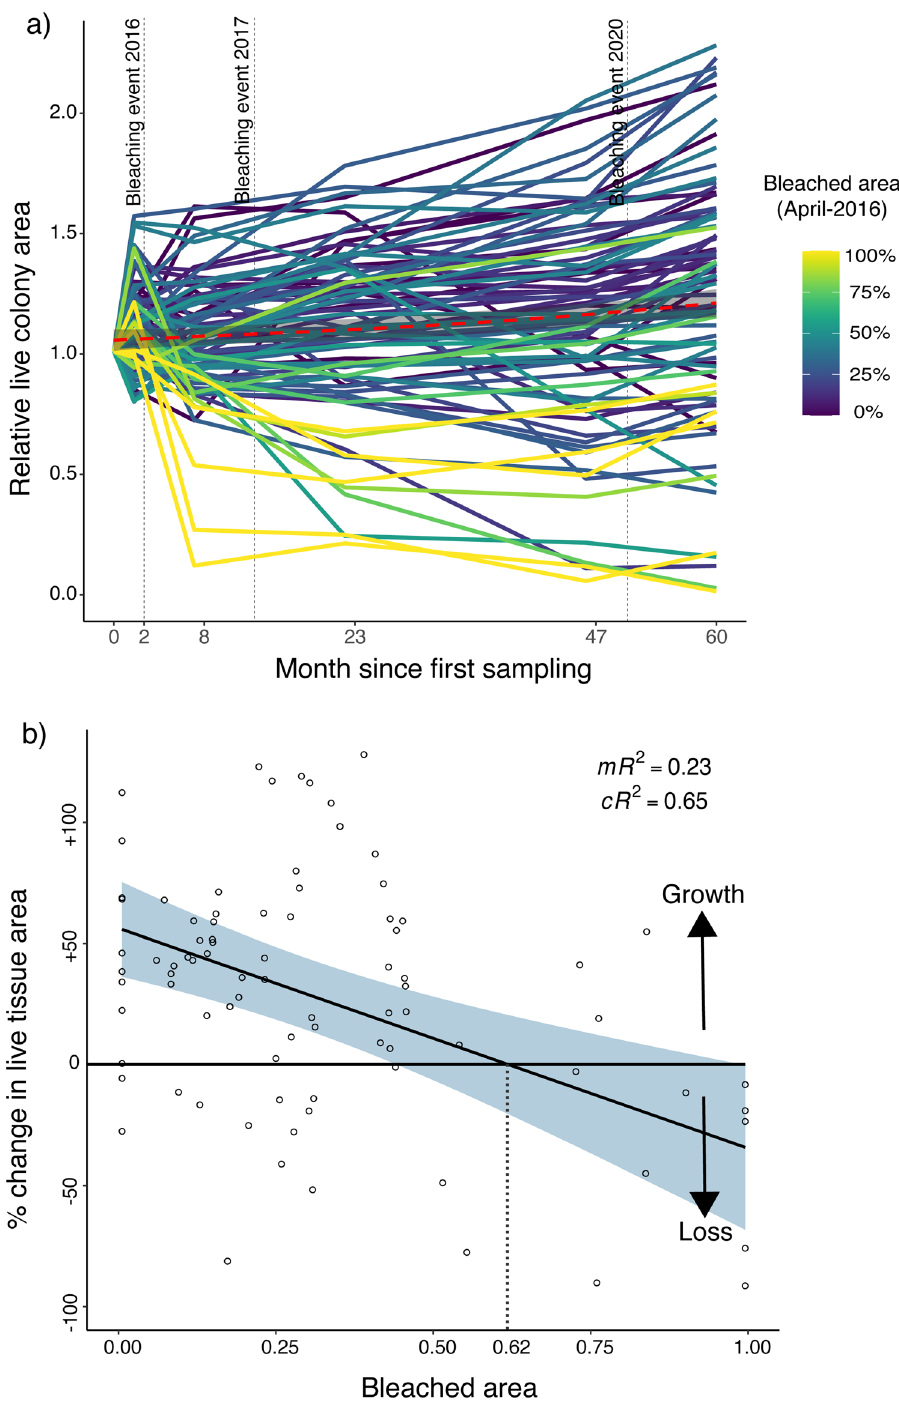
Figure 4. ( a ) Relative area of live tissue on massive Porites colonies over 60 months. Each line represents a single colony, with line colors representing the proportion of bleaching in each colony (during the 2016 bleaching event). The red dotted line represents the average increase of 21% in colony area of massive Porites . ( b ) Effect of the proportional bleached area (in April-2016) on the subsequent relative change in live tissue area of massive Porites . Line and band show the prediction and 95% confidence intervals of a Gamma GLMM, while dots show raw data points. Modelling was performed in the software R 34 , using the glmmTMB package 35 . The solid horizontal line and arrows indicate where colonies effectively increased or decreased live tissue area. The dotted vertical line represents the minimum bleached area required, on average, to trigger tissue loss. mR 2 = marginal R 2 and cR 2 = conditional R 2